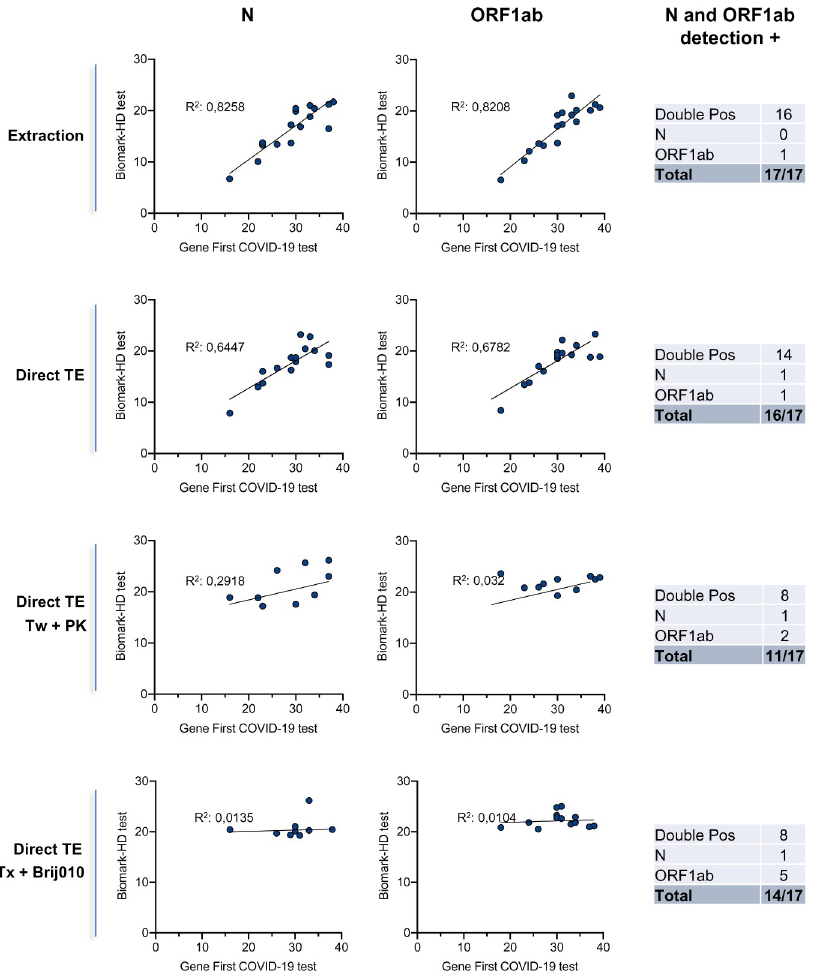
Fig 6. Correlation of the detection of two viral genes (N, ORF1ab) obtained using a commercial COVID-19 detection kit and extraction-based or direct Biomark-HD assays. We used a set of 17 clinical samples from SARS-CoV-2-diagnosed patients collected in saline solution with a wide range of Cq values. To control pH conditions and limit RNA degradation, all samples were diluted 2X in TE buffer. RNA was extracted (as a control) or samples were treated using Tween 20 and PK (Tw + PK) or Triton X-100 and Brij010 detergent solutions (Tx + Brij010). The different RT-qPCR Biomark methods were compared with the GeneFirst TM COVID-19 method as a reference. The correlation between the Cq obtained with the two methods is presented. One negative sample was processed in the three direct conditions (TE, TE plus Tw + PK and TE plus Tx + Brij010) with as results an absence of signal with the two probes (Cq > 40). Double Pos: double